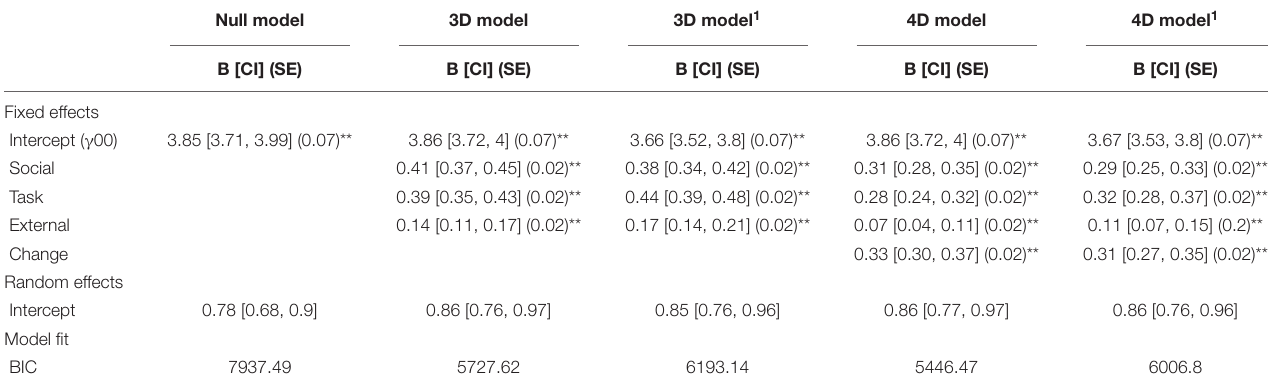
TABLE 3 | Multilevel regression models: estimates and fit (athletes).